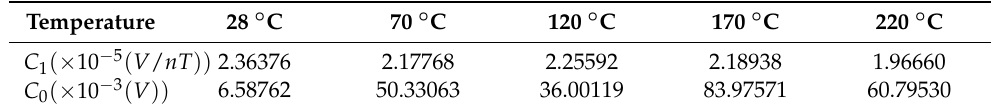
Table 2. Normalized parameters of temperature calibration test. The parameters in the table corre- spond to ˆ U S = C 1 · B A − C 0 .